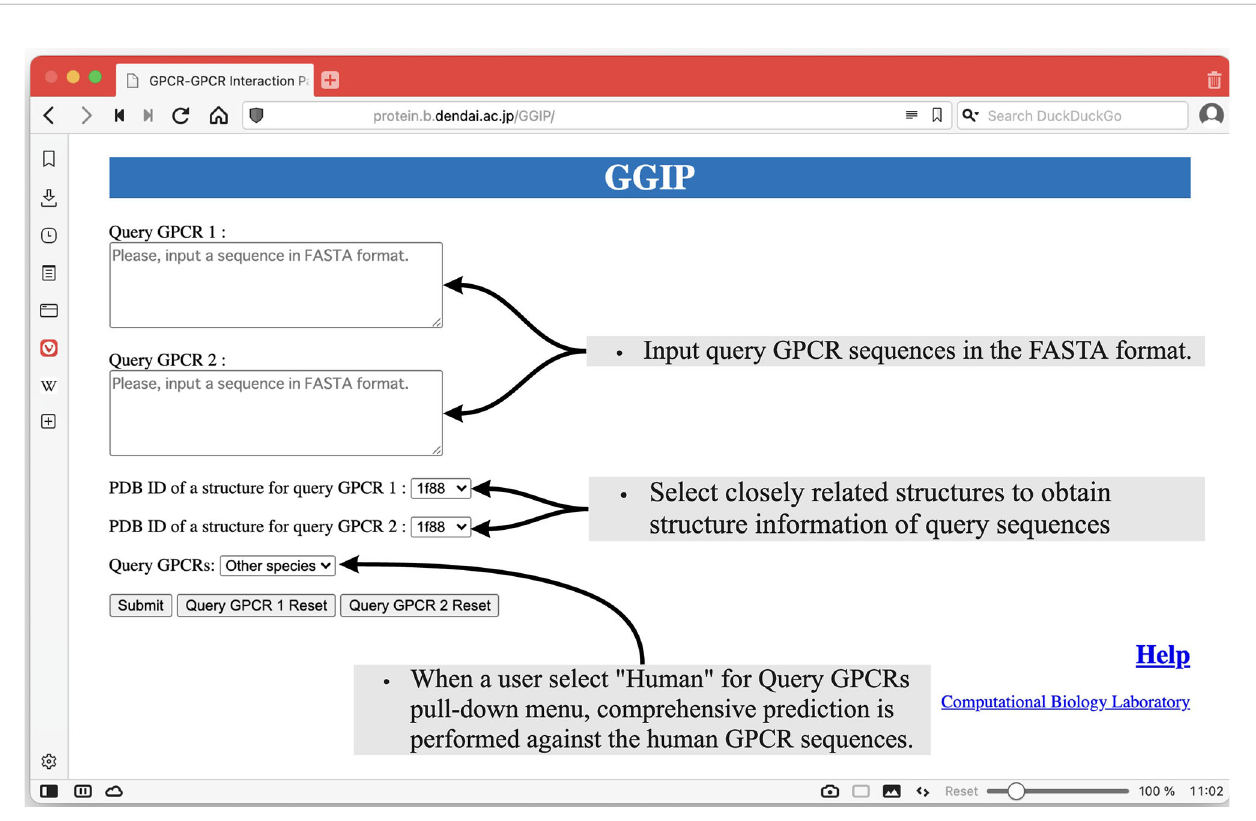
FIGURE 2 | Input page of